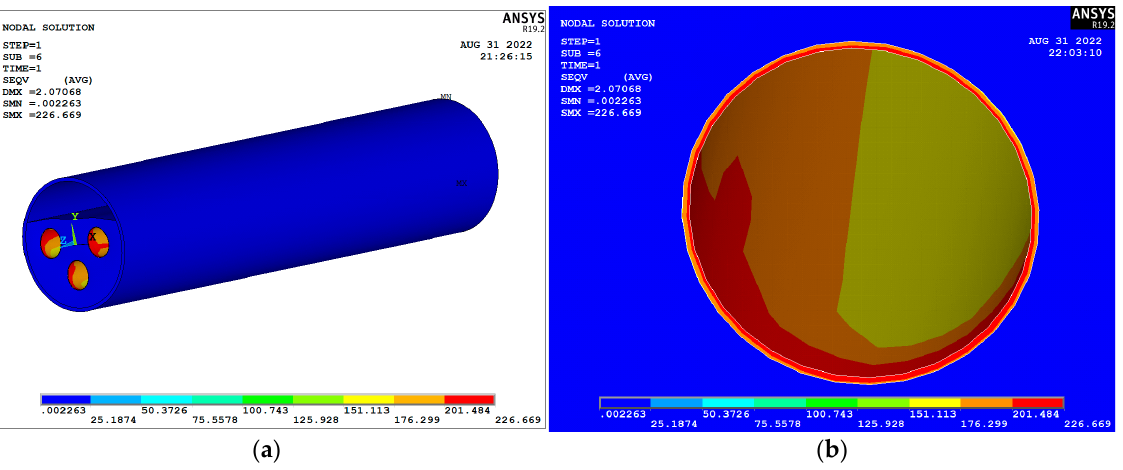
Figure 15. Stress cloud chart under operating pressure: ( a ) Natural gas transmission tunnel;( b ) Gas pipeline.